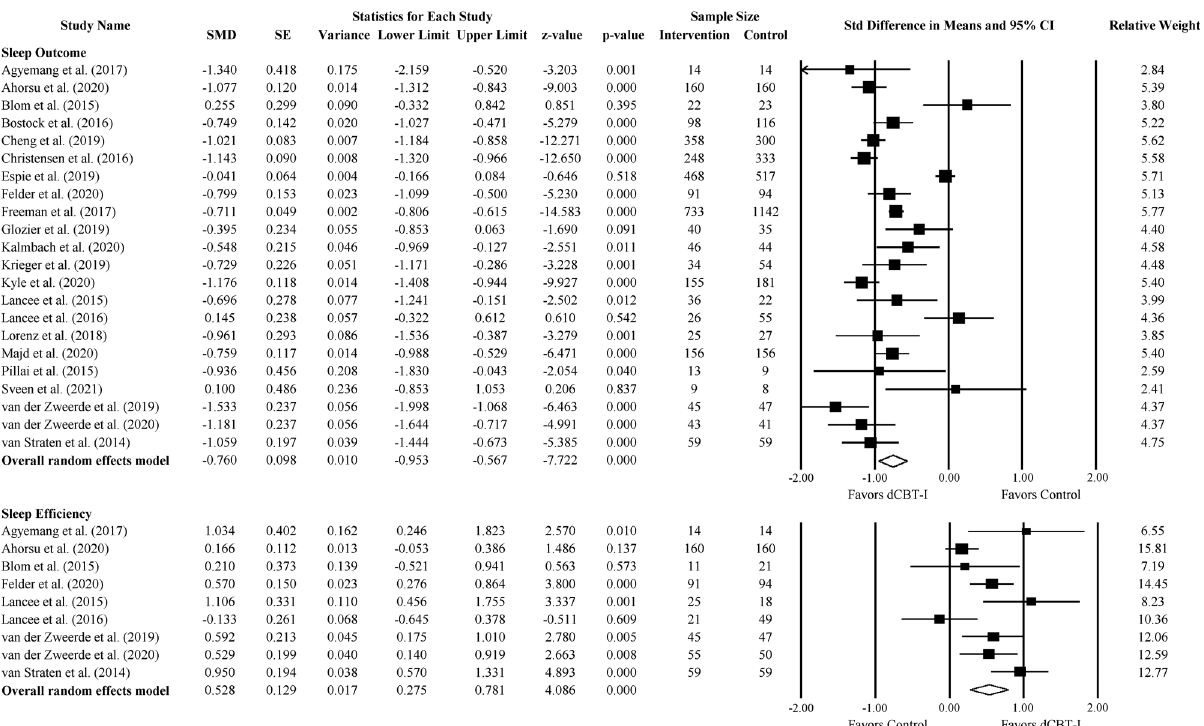
Fig. 4 The effect of dCBT-I on sleep outcome and sleep ef fi ciency. Forest plot of studies reporting the effect of dCBT-I on sleep outcome and sleep ef fi ciency.